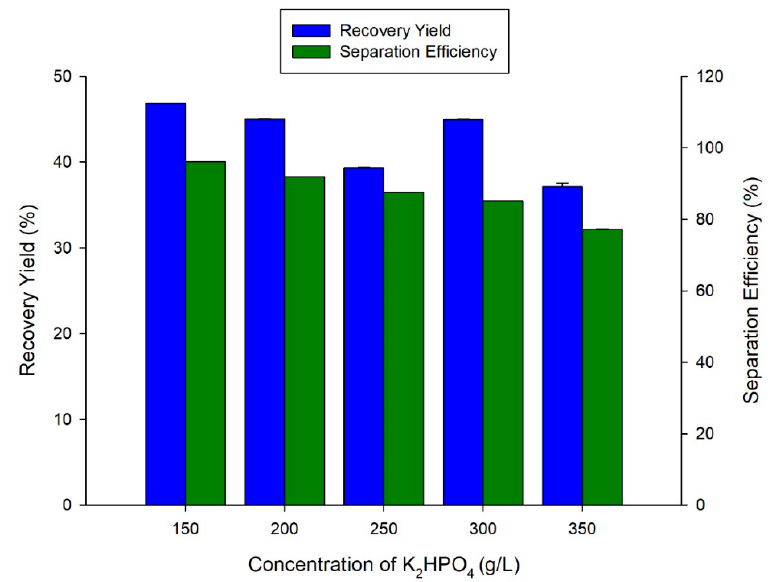
Figure 4. Figure illustrating effect of various K 2 HPO 4 concentrations on protein recovery yield and separation efficiency using LBF system.